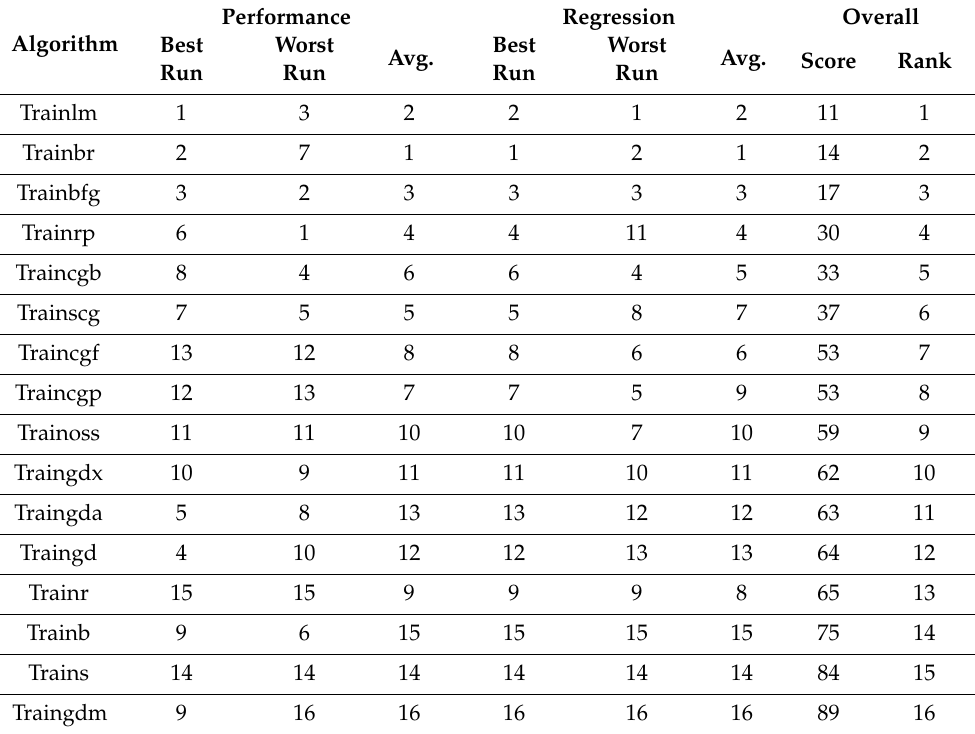
Table 6. Algorithm performance